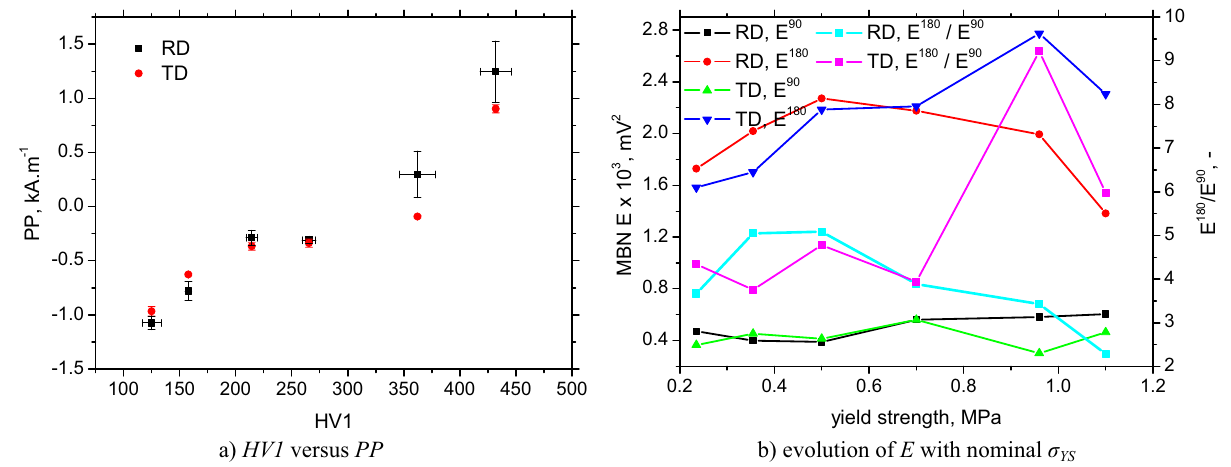
Figure 15. Number of DWs versus MBN; evolution of E with nominal σ YS